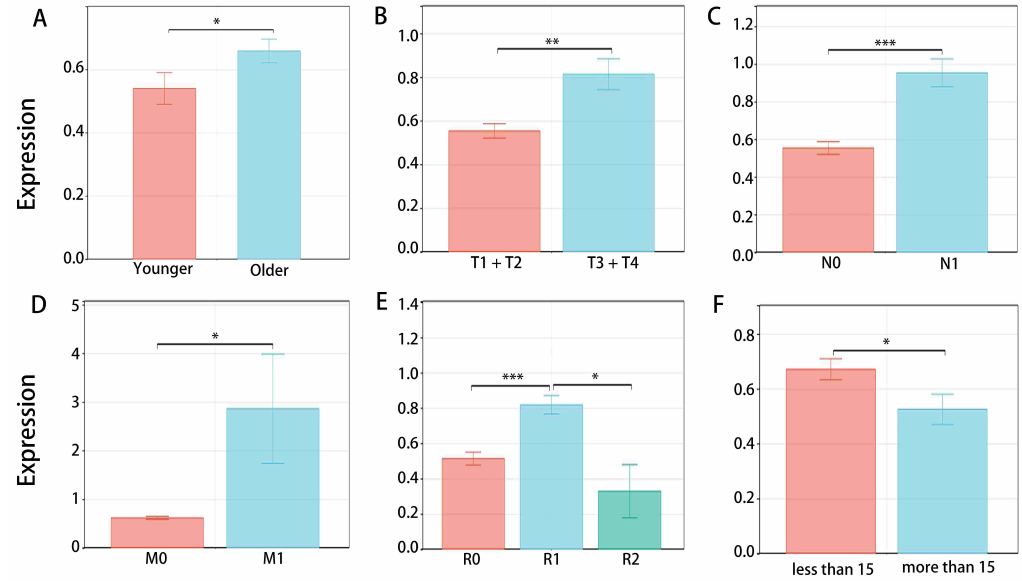
FIGURE 5. The correlation between clinical characteristics and risk score. (A) age. (B) T stage. (C) N stage. (D) M stage. (E) residual tumor. (F) number of lymphnodes. Younger indicated the age < 60, and older indicated age ≥ 60.